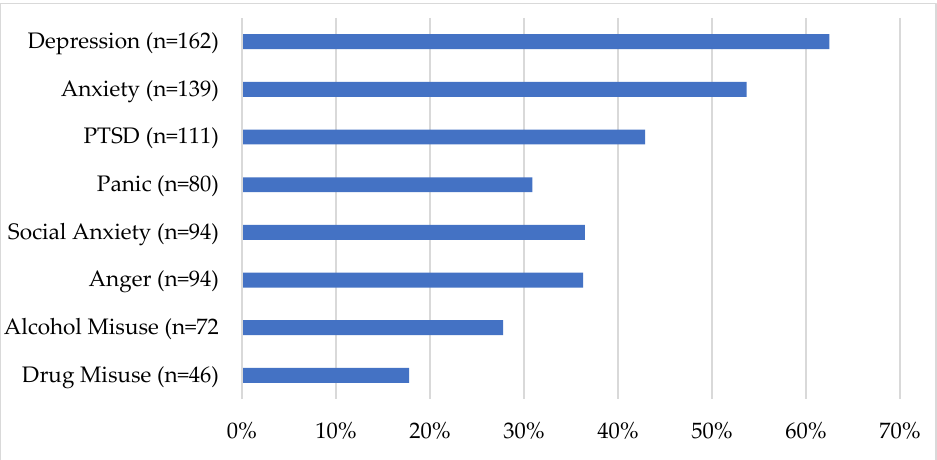
Figure 7. Percentage of PSP reporting clinically significant symptoms on each measure.